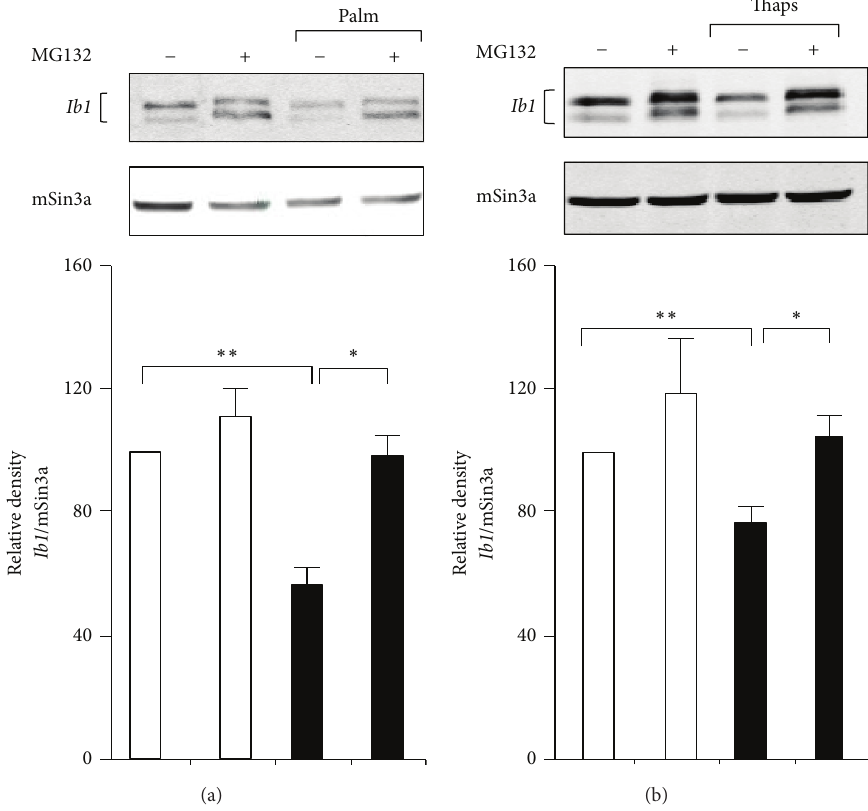
Figure 3: Effect of the proteasome inhibitor MG132 on the decrease of Ib1 content caused by palmitate. Ib1 content was measured from MIN6 cells exposed to (a) 0.5 mM palmitate or (b) 1 𝜇 M thapsigargin (thaps) for 48 hrs in the presence or absence of 1 𝜇 M of the proteasome inhibitor MG132. The Ib1 level was normalized against the mSin3a. The figure shows the result of a representative experiment out of three. The results are expressed as the mean ± SEM of three independent experiments ( ∗∗ 𝑃 < 0.01 ; ∗ 𝑃 < 0.05